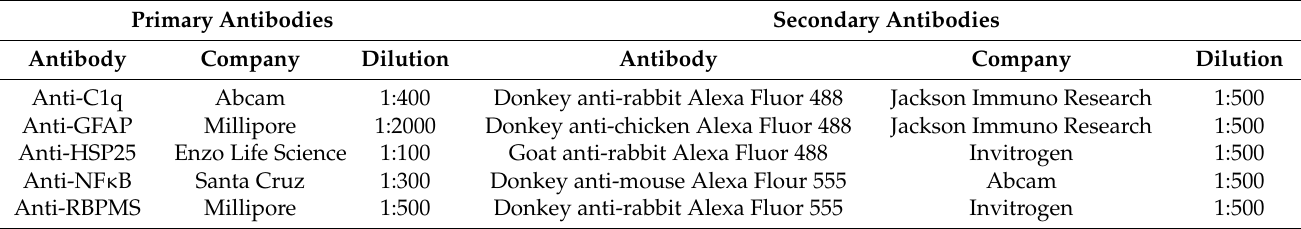
Table 2. Primary and secondary antibodies used for